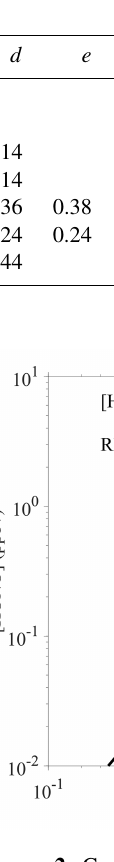
Figure 2. Correlation between [HONO] and [NO x ] during the 9 February to 14 March 2018 campaign. The black line represents a linear fit with a zero